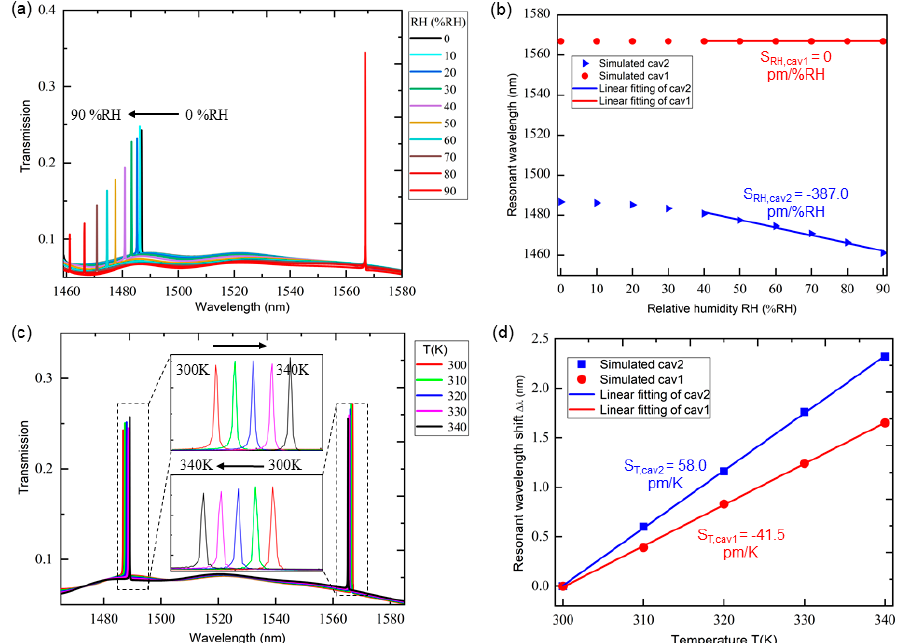
Figure 7. ( a ) Transmission spectra under various RH changes. ( b ) The linear fitting of corresponding resonant wavelength during the time when RH changes from 0% RH to 90% RH in 10% RH steps (T = 300 K). ( c ) Transmission spectra under different temperature. ( d ) Linear fitting of relevant res ‐ onant wavelength shift versus different temperatures, from 300–340 K with 10 K steps (RH = 40%RH).